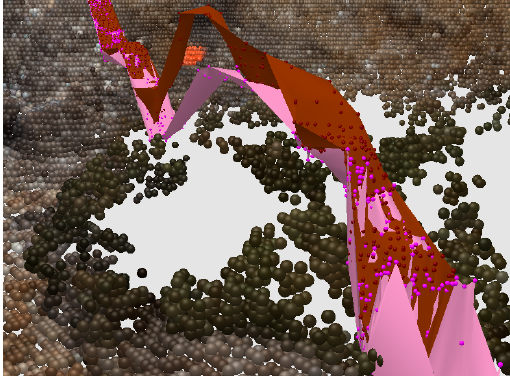
Figure 8: 6 cm wide strips of Poisson and TIN surfaces viewed over a vegetated section of the points clouds from which they were derived (Z-10 cm), each natural coloured dot has a 14mm